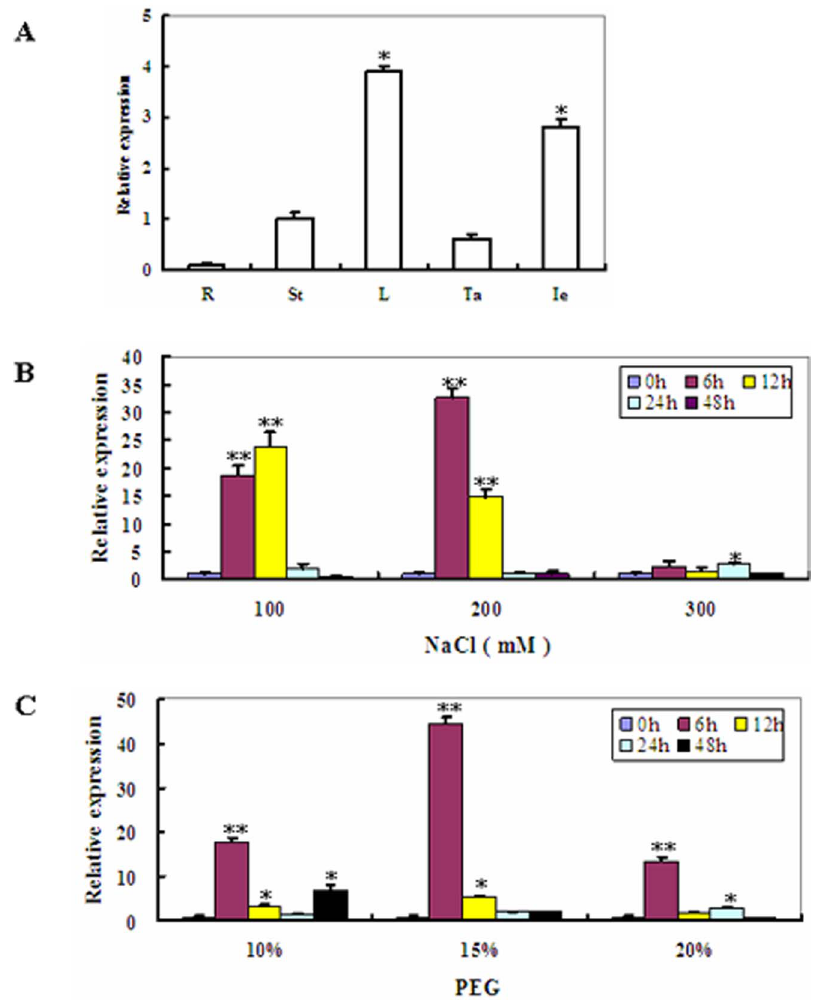
Figure 2. Transcript profiles of ZmSKD1 in major organs of maize and its responses to salt and drought stresses. A The transcriptional pattern of ZmSKD1 in maize root (R), stem (St), leaf (L), tassel (Ta) and immature ear (Ie) samples evaluated by real-time PCR. For each real-time PCR, the transcript levels of maize internal control gene Ubiquitin were also evaluated in various samples. For each assay, the expression level in stems was defined as 1.0, and data represented means 6 SE of three technical replicates. *t-test, with P , 0.05. B Time-course analysis of ZmSKD1 transcript levels under various concentrations of salt treatments by real-time PCR. Two-week-old maize seedlings were exposed to 100, 200, and 300 mM NaCl for indicated time points (0, 6, 12, 24, and 48 h), and leaf samples were used for real-time PCR analysis. C Time-course analysis of ZmSKD1 transcript levels under PEG-induced water stress by real-time PCR. Two-week-old maize seedlings were exposed to 0, 10%, 15%, and 20% PEG6000 for indicated time points (0, 6, 12, 24, and 48 h), and leaf samples were used for real-time PCR analysis. In both B and C assays, Ubiquitin was used as an internal control. For each treatment, the expression level at time point 0 was defined as 1.0, and data represented means 6 SE of three technical replicates. **t-test, with P , 0.01; *t-test, with P ,